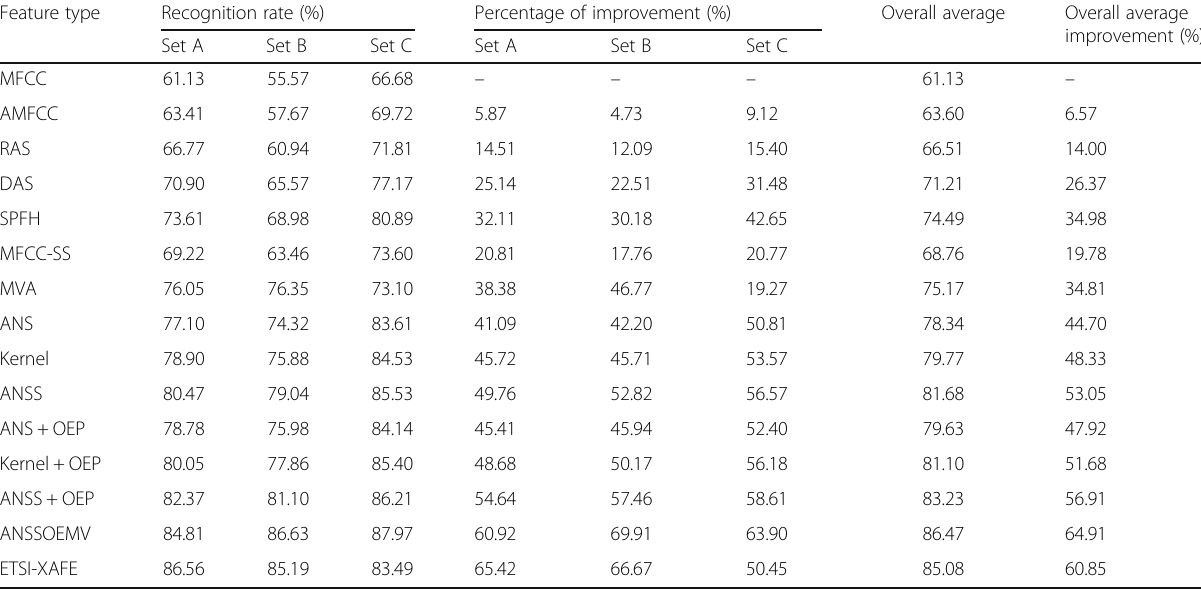
Table 3 Comparison of average recognition rates and percentage of improvement in comparison to MFCC for various feature types on three test sets of Aurora 2 task Feature